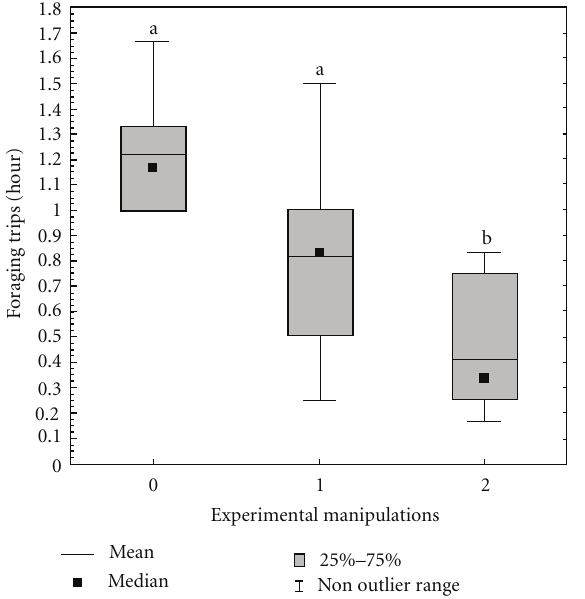
Figure 2: Box-plots indicating the means, median, 25th and 75th percentiles and non-outlier range of the data set used to compare the e ff ect of the number of removals regardless the female hierarchical position. When compared with the control (0), the removal of 2 or 3 females, regardless of their social position, decreased significantly the mean number foraging trips/hour of Mischocyttarus cerberus styx (0: no manipulation; 1: removal of 1 female; 2: removal of 2 females; 3: removal of 3 females). Statistical significance at the level of